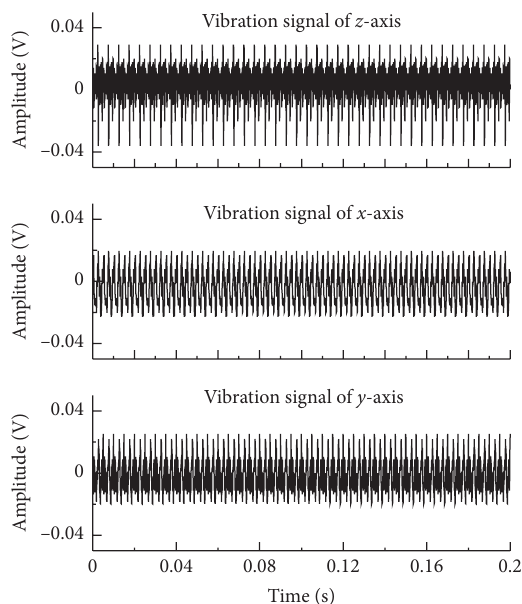
Figure 13: Time-domain diagrams of vibration signals of axial piston